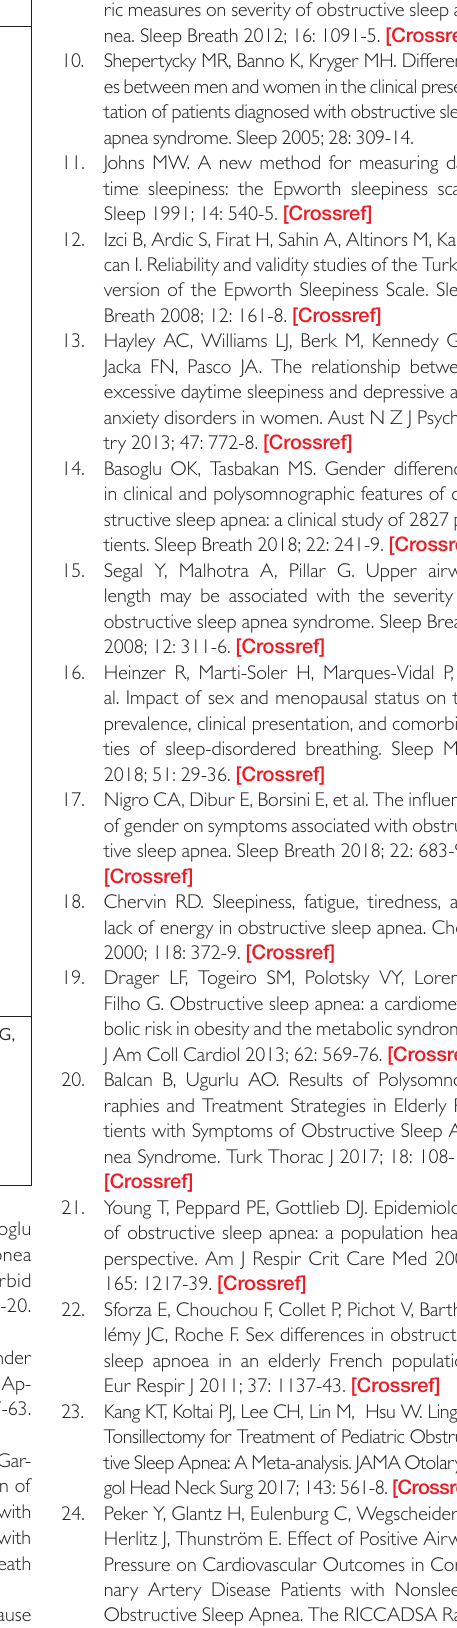
Table 4. Associates of obstructive sleep apnea (AHI ≥ 15 events/h) in females and males OR 95%